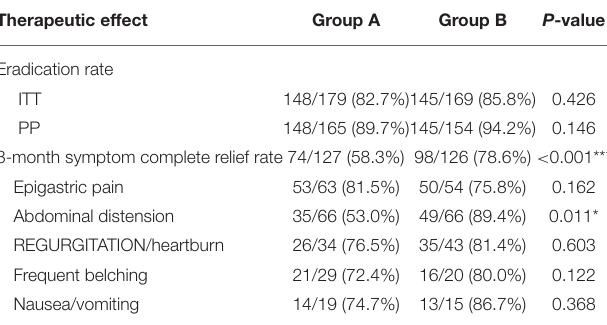
TABLE 2 | Comparison of clinical therapeutic effect analysis between two